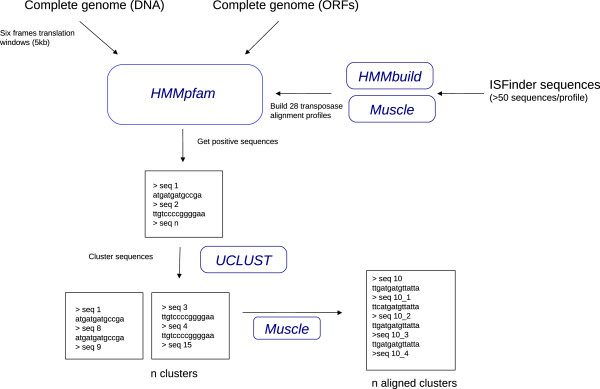
Simplified workflow of the profile HMM search. Running softwares are indicated in blue, rectangles schematize the different output files at each step.